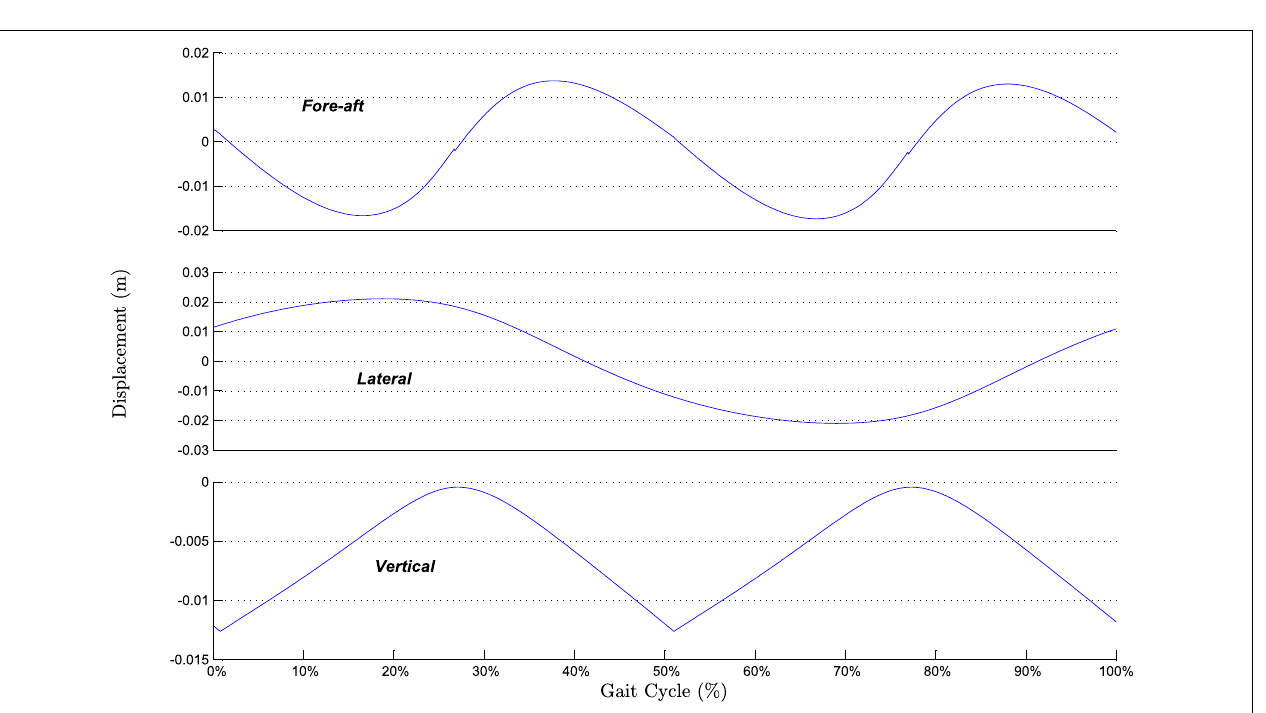
Frontiers in Robotics and AI |